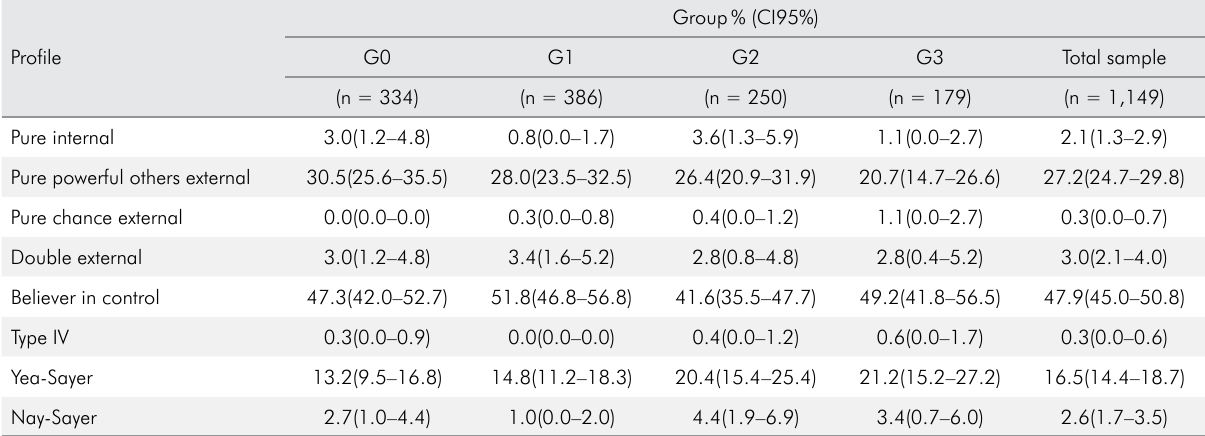
Table 8. Prevalence (point estimate and 95% confidence interval, or CI with different pain